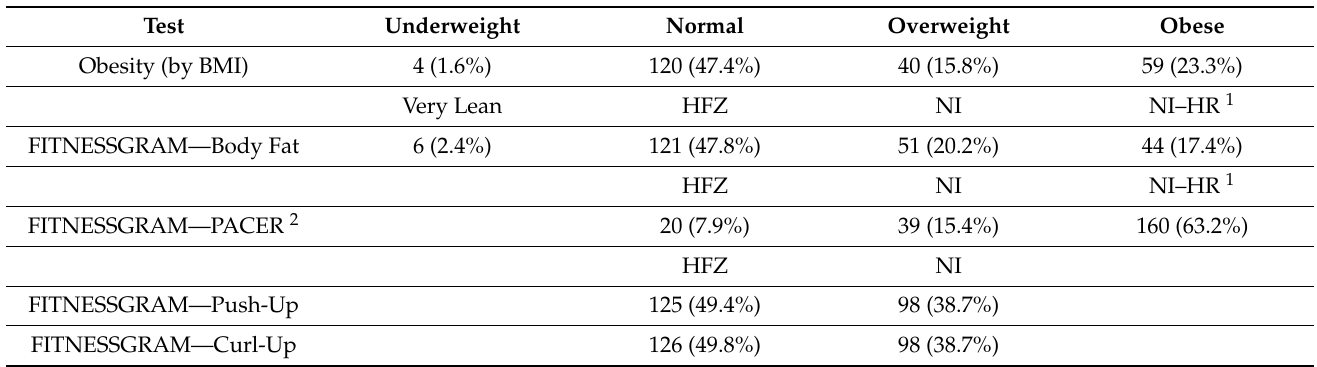
Table 3. FITNESSGRAM